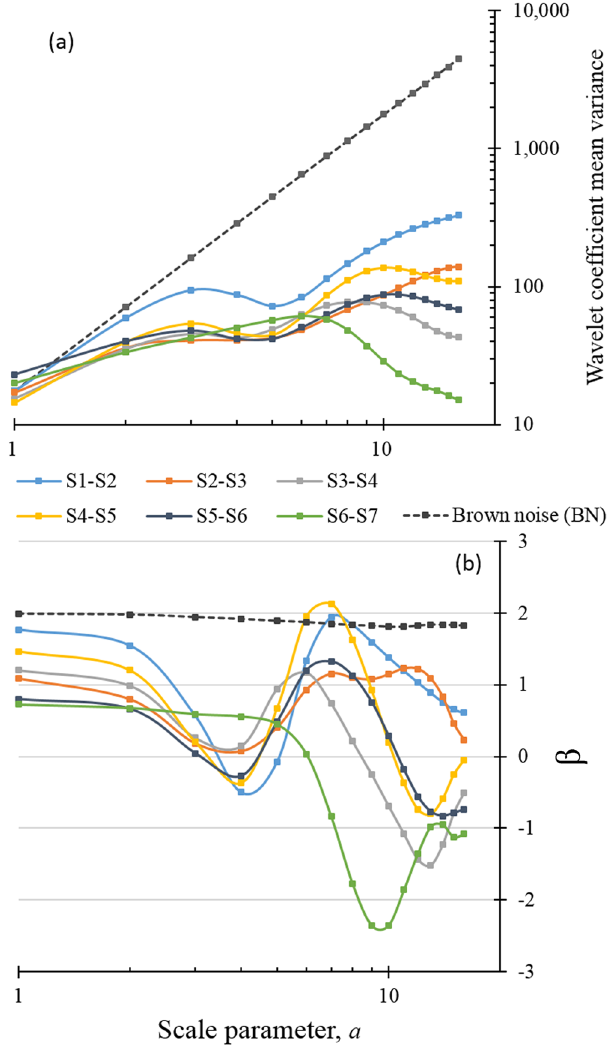
law relationships between the power-spectral density and scale; β is calculated from the data points in ( a